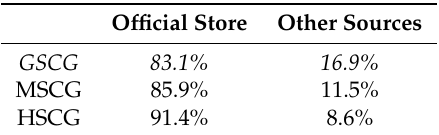
Table 5. Where do you download applications